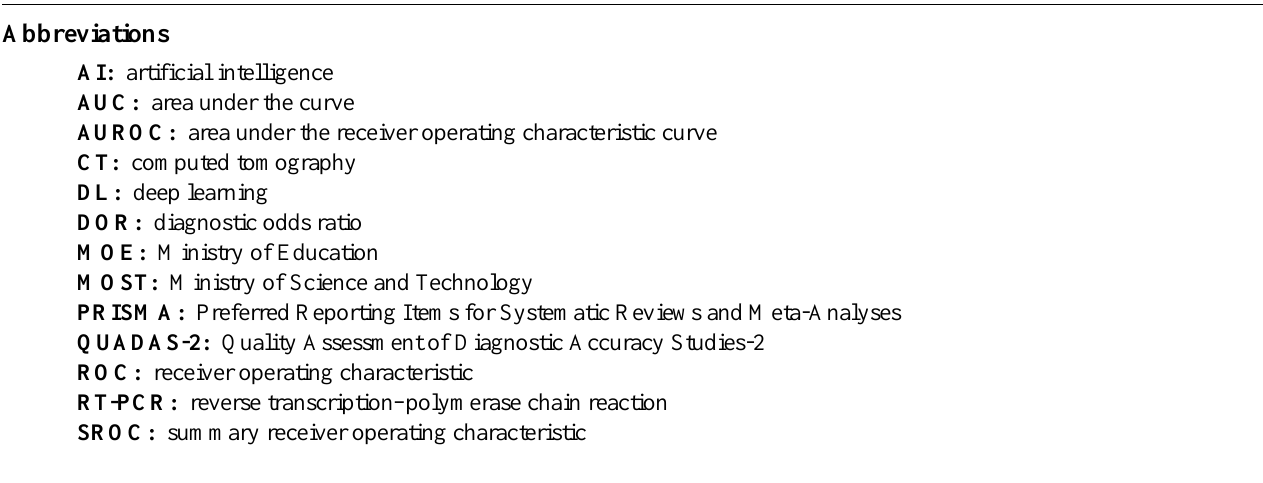
Abbreviations AI: artificial intelligence